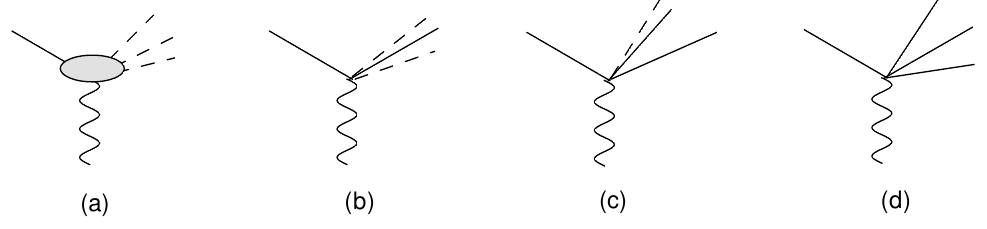
Figure 6 . Schematic diagrams of the \Projection-to-Born" method, including the inclusive contri- butions, followed by separate contributions from the double-unresolved region, the single-unresolved region, and the fully-resolved